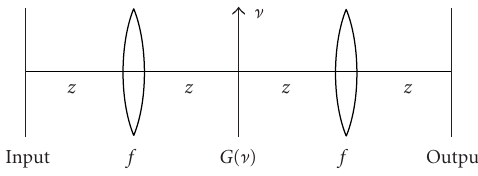
Figure 5: Schematic representation of a (fractional) Hilbert trans- former: z = f , G ( ν ) = exp[ iα sgn( ν